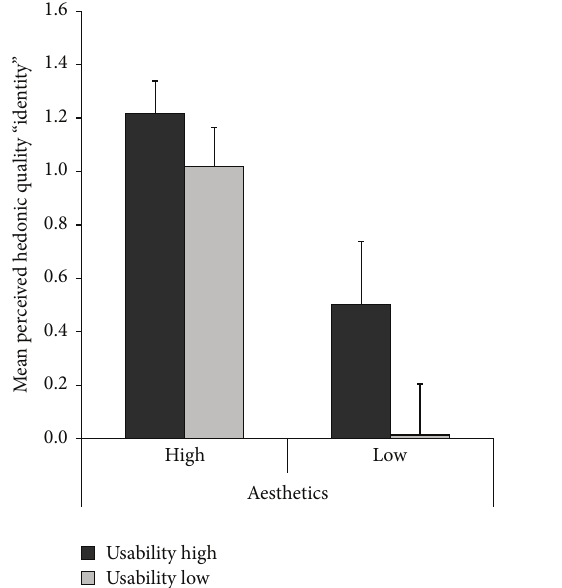
Figure 8: Mean rating of the perceived appeal of the mobile depending on the mobile’s manipulated usability (high versus low) and the manipulated aesthetics (high versus low). Note that the scale ranges from − 3 to +3. Vertical lines indicate the standard error of the